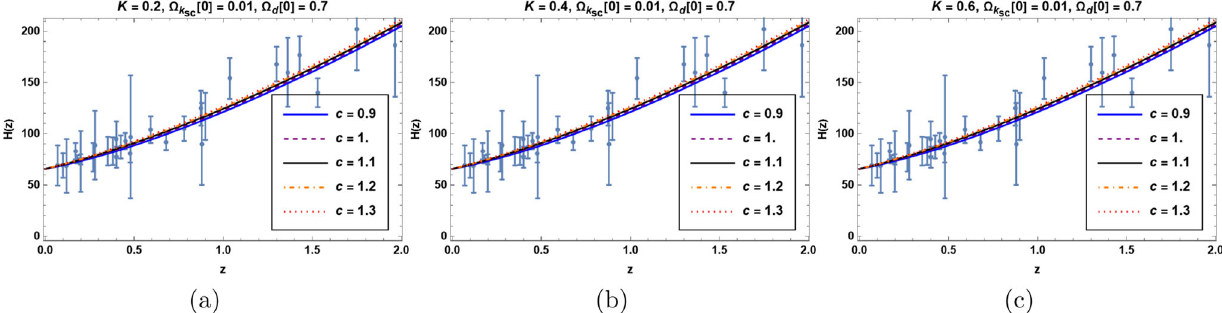
Fig. 9 The variation in the Hubble parameter H with redshift z for the closed universe, in units when M 2 p = 1 , H 0 = 67 . 9. In order to be consistent with data, we now imposed (cid:2) d ( x = − ln ( 1 + z ) = 0 ) = (cid:2) d [ 0 ] = 0 . 7. Bars represent the 30 H ( z ) datapoints